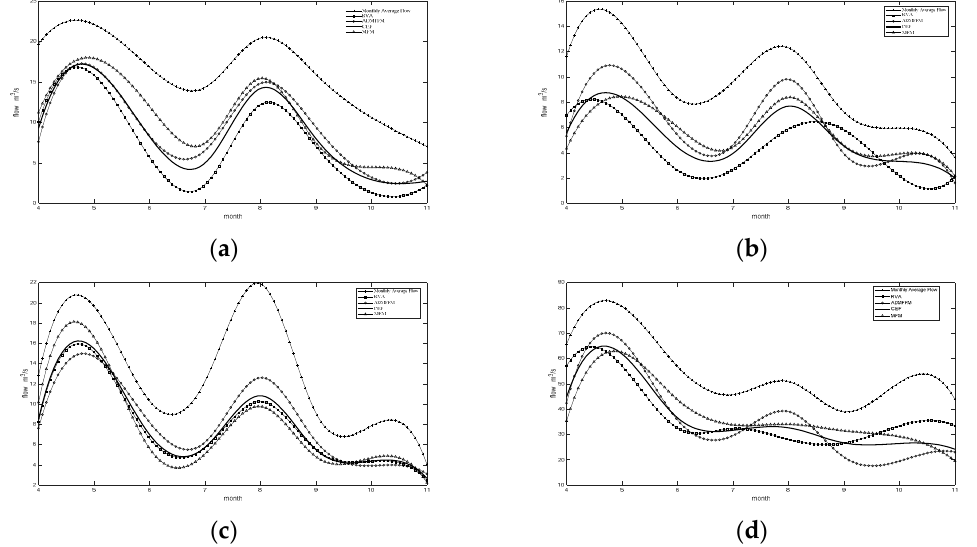
Figure 6. Ecological flow calculation results: ( a ) Baoqing, ( b ) Baoan, ( c ) Hongqiling, and ( d ) Caizuizi stations.